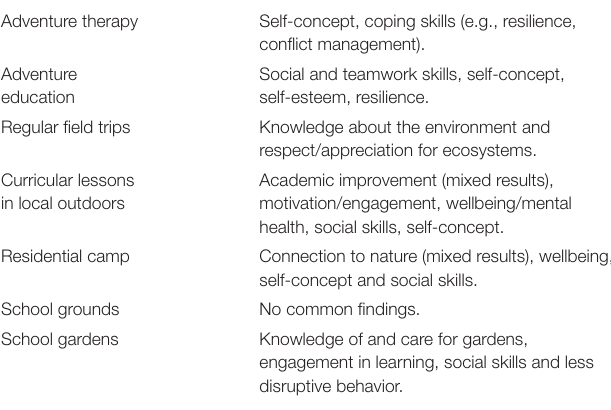
TABLE 6 | Common research outcomes by outdoor learning context. Adventure